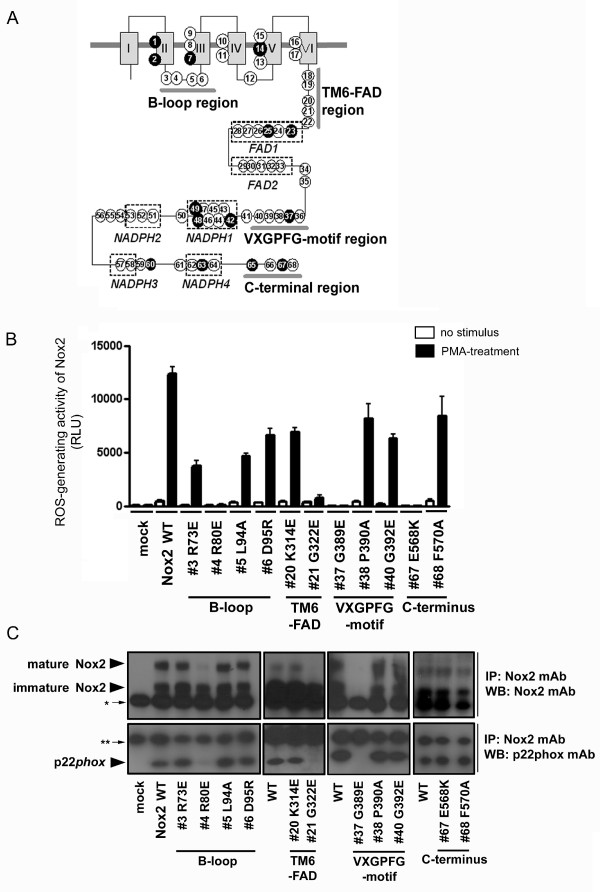
Effects of mutations of conserved amino acids on Nox enzymatic activity and formation of the Nox2-p22phox complex. (A) Conserved amino acids (circles) are indicated on a schematic of the Nox domain, and residue numbers corresponding to the human Nox2 protein sequence are keyed in Figure 6. Filled circles indicate known point mutations in individual variants of X-linked CGD. (B) HEK293 cells that constitutively express p22phox were co-transfected with wild type (WT) or the indicated mutations of Nox2 along with p47phox, p67phox, and Rac1(V12G) or with empty vector (mock). Each point mutation of human Nox2 is indicated by the single letter amino acid code. ROS production was measured as described, and the values are presented as mean ± SD (n = 4). These experiments have been repeated three times with similar results. (C) Nox2 and p22phox protein expression was probed by Western blotting (WB) with monoclonal antibodies 54.1 and 44.1, respectively. Proteins were immunoprecipitated (IP) with antibody 54.1 prior to SDS-PAGE. The asterisks indicate IgG heavy chain (* in upper panels) and light chain (** in lower panels). Nox2 protein is expressed as both unglycosylated (65 kDa, immature) and glycosylated (90–100 kDa, mature) forms. p22phox co-immunoprecipitated with Nox2 was seen at 22 kDa. These experiments have been repeated more than three times with similar results.